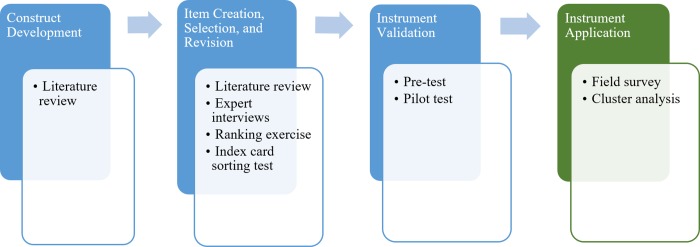
Research approach.